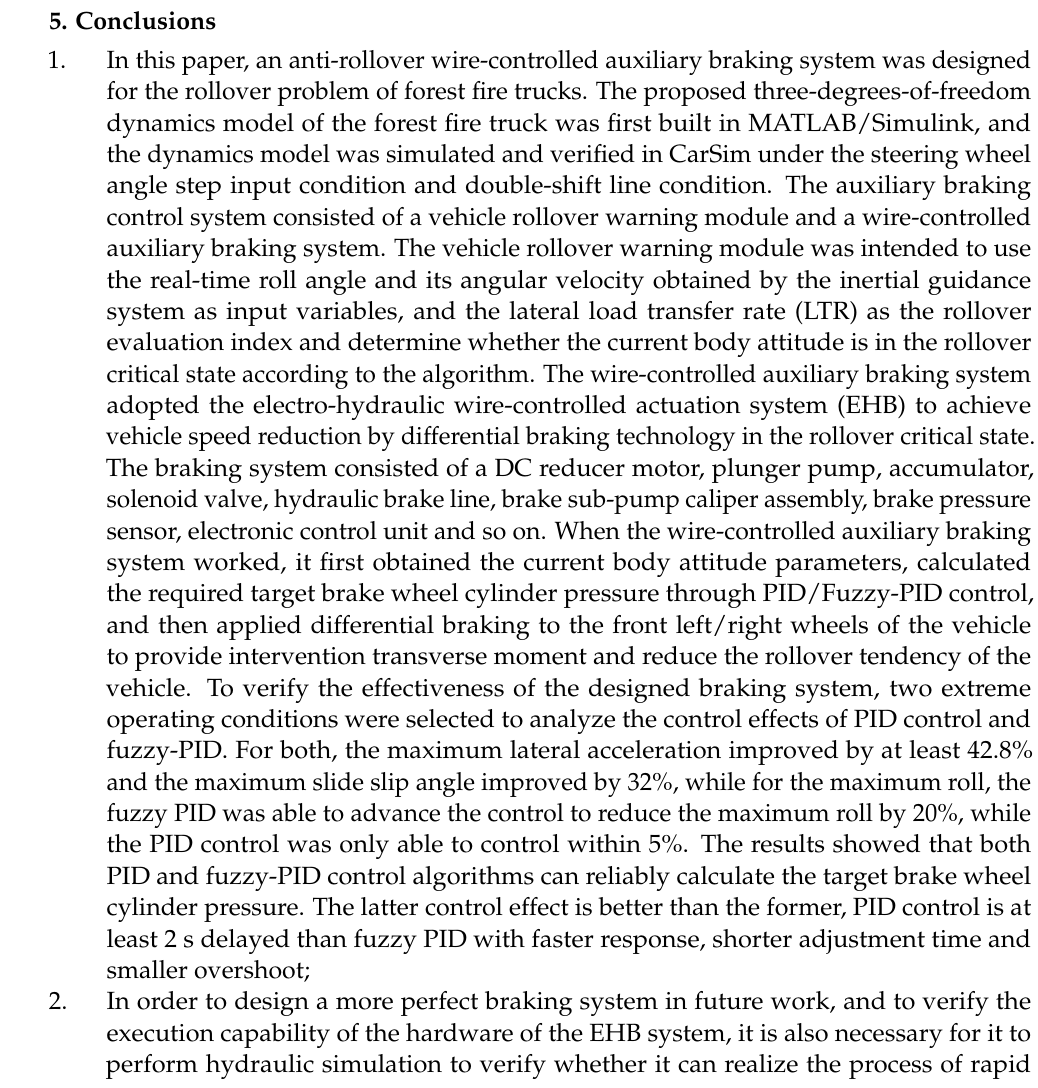
Figure 16. Response curve of J-turn condition: ( a ) LTR; ( b ) yaw rate; ( c ) lateral acceleration; ( d ) side slip angle; ( e ) roll; and ( f ) braking torque.